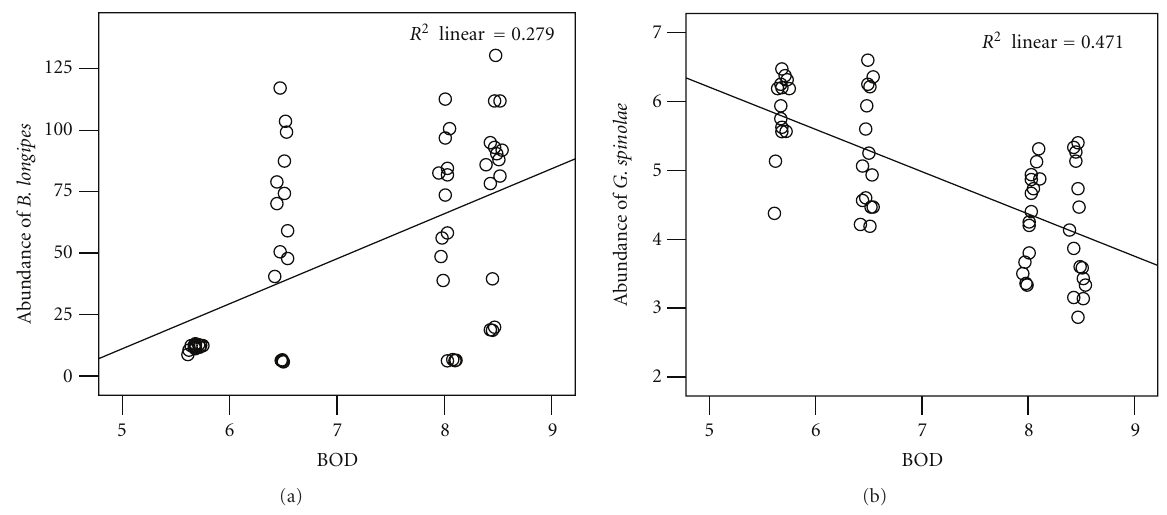
Figure 3: Relation between BOD and abundance of (a) Brachydeutera longipes (Hendel) and (b) Gerris spinolae (Lethierry and Severin) as shown by regression